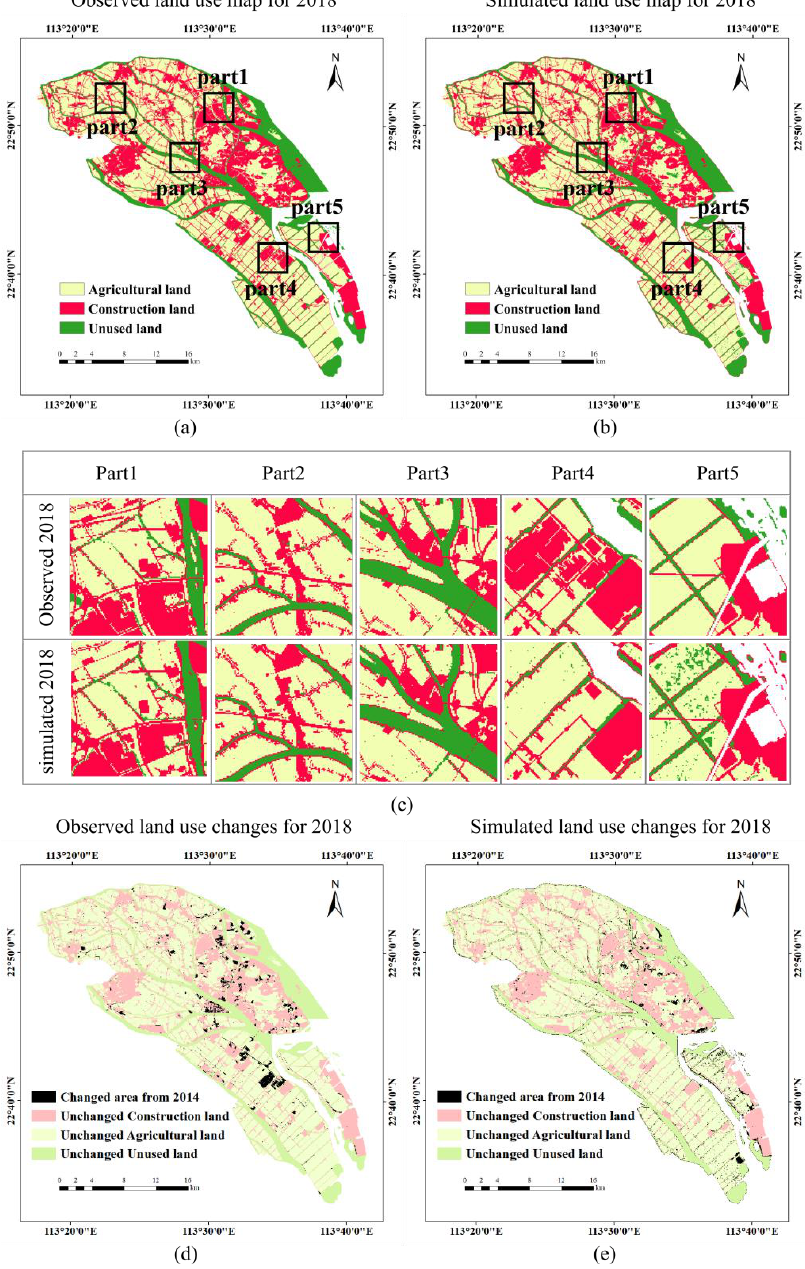
Figure 5. Comparison of observed land use map and simulated map for 2018: ( a ) Observed land use map for 2018; ( b ) Simulated land use map for 2018; ( c ) Comparison of observed map and simulated map from part1 to part5; ( d ) Observed land use changes for 2018; ( e ) Simulated land use changes for 2018.